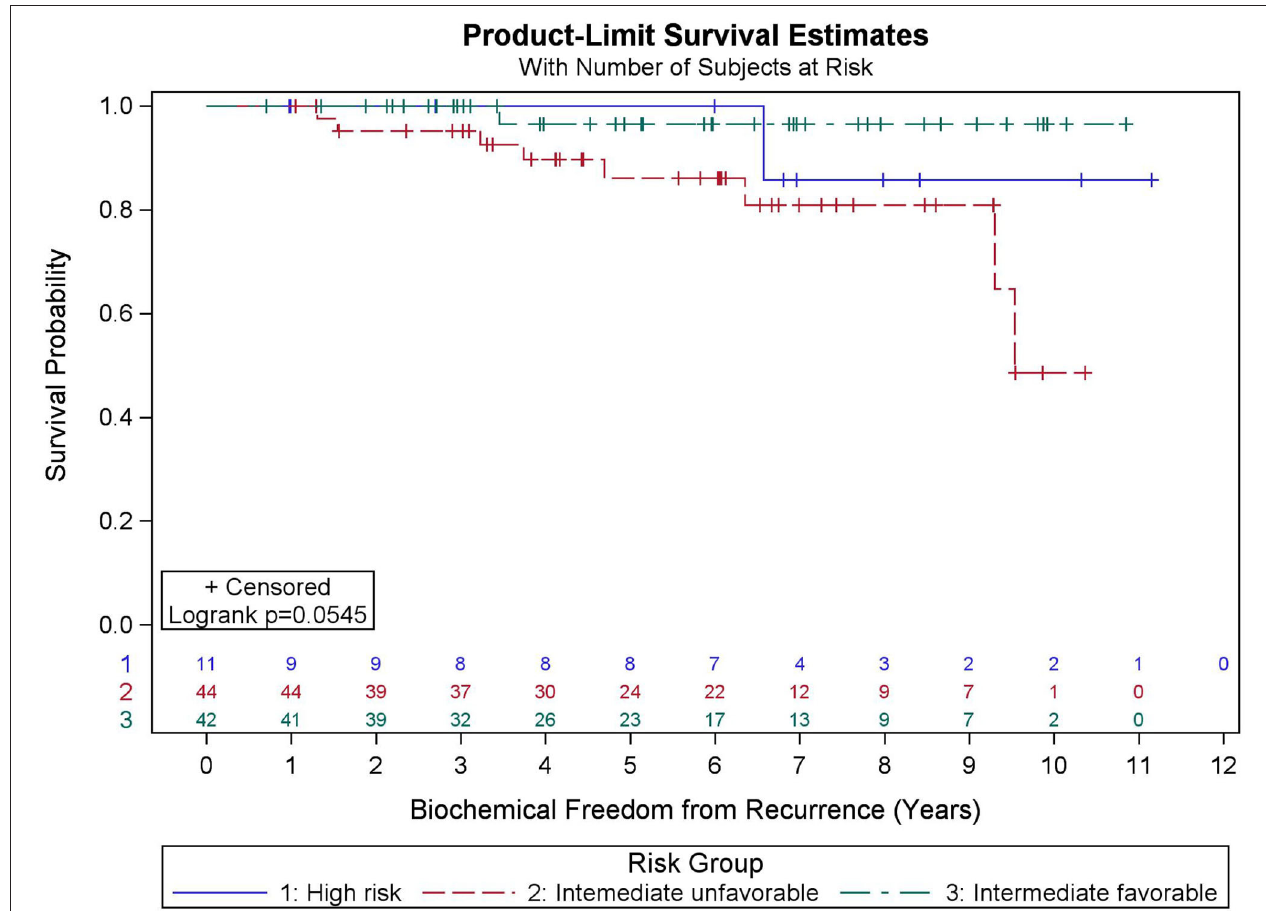
FIGURE 4 | Kaplan–Meier curves for biochemical freedom from recurrence by risk